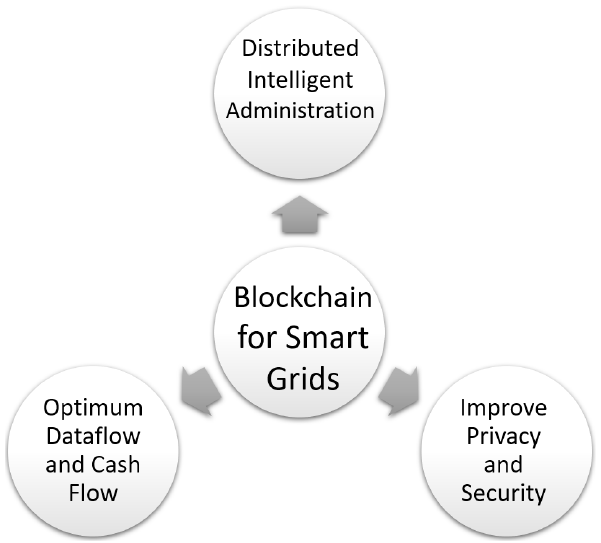
Figure 8. Blockchain for smart